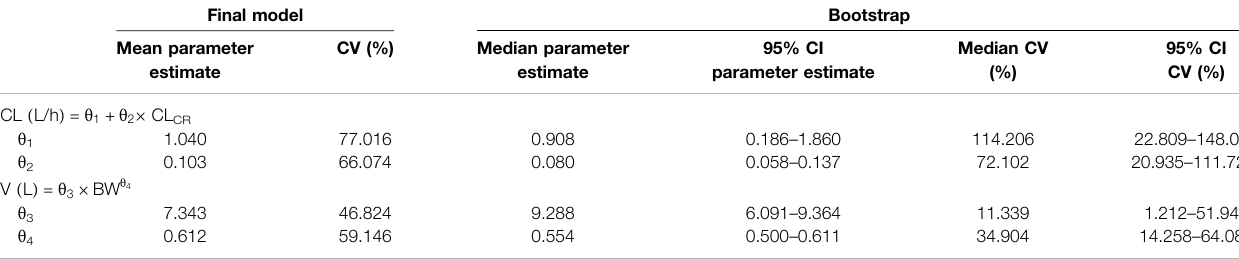
TABLE 4 | Parameter estimates of continuous infusion meropenem for the fi nal population pharmacokinetic model.